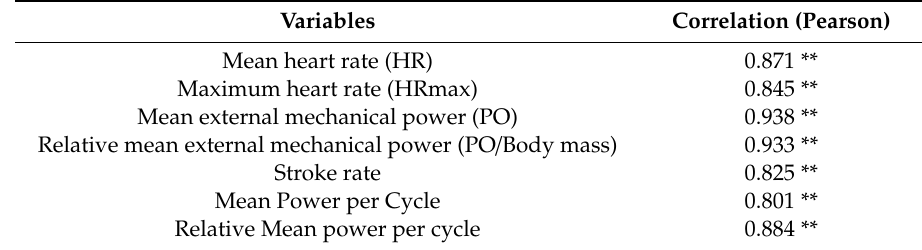
Table 3. Correlations (Pearson) between the physiological, mechanical, and kinematic variables observed in the morning and afternoon time